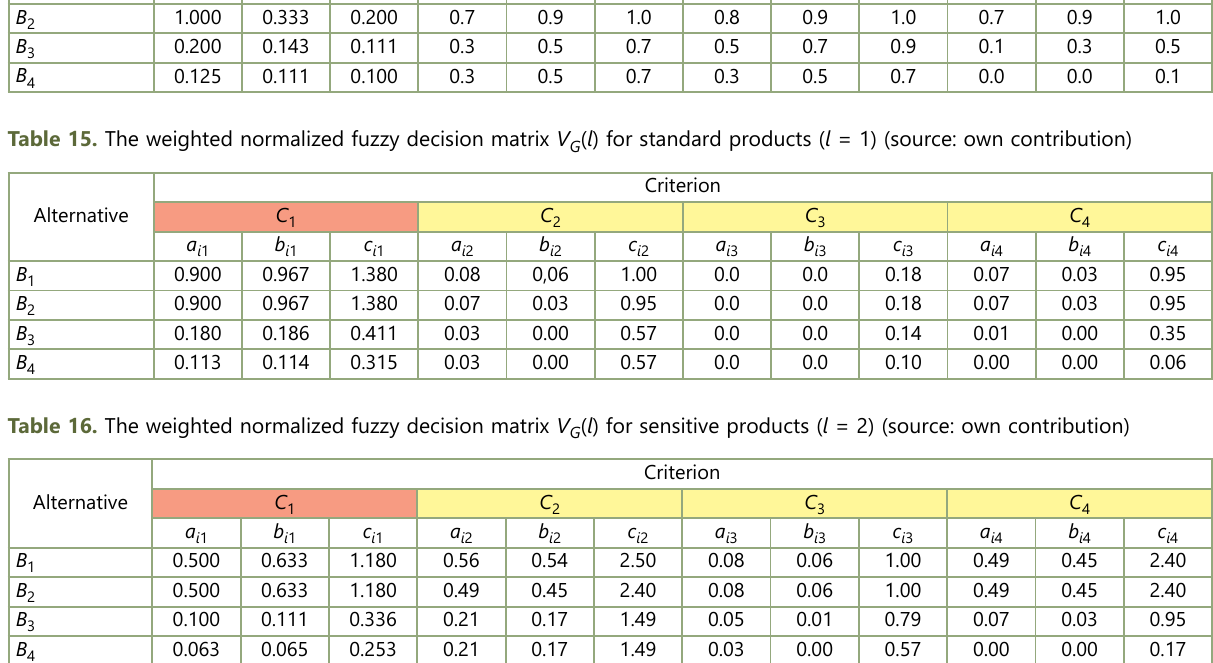
Table 17. The weighted normalized fuzzy decision matrix V G ( l ) for food ( l = 3) (source: own contribution)